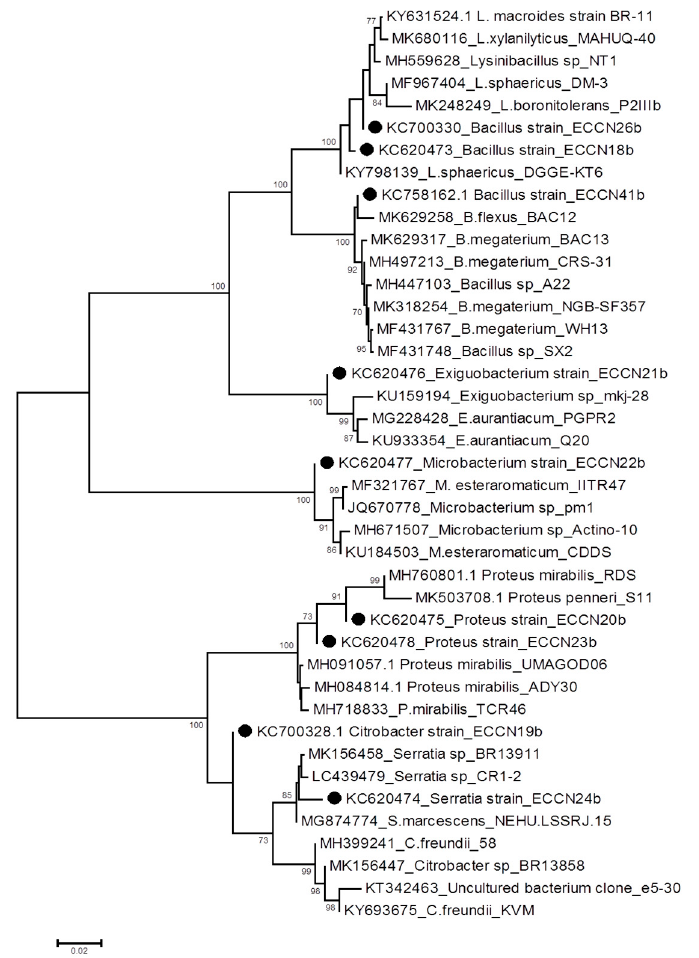
Figure 1. Phylogenetic tree showing relation between coal-degrading bacterial isolates ( • ) and reference PGP strains contained in the NCBI GenBank database. GenBank accession numbers and the corresponding taxonomic annotations are shown to the right of the strains. Bootstrap values of ≥ 70% are shown at the nodes.